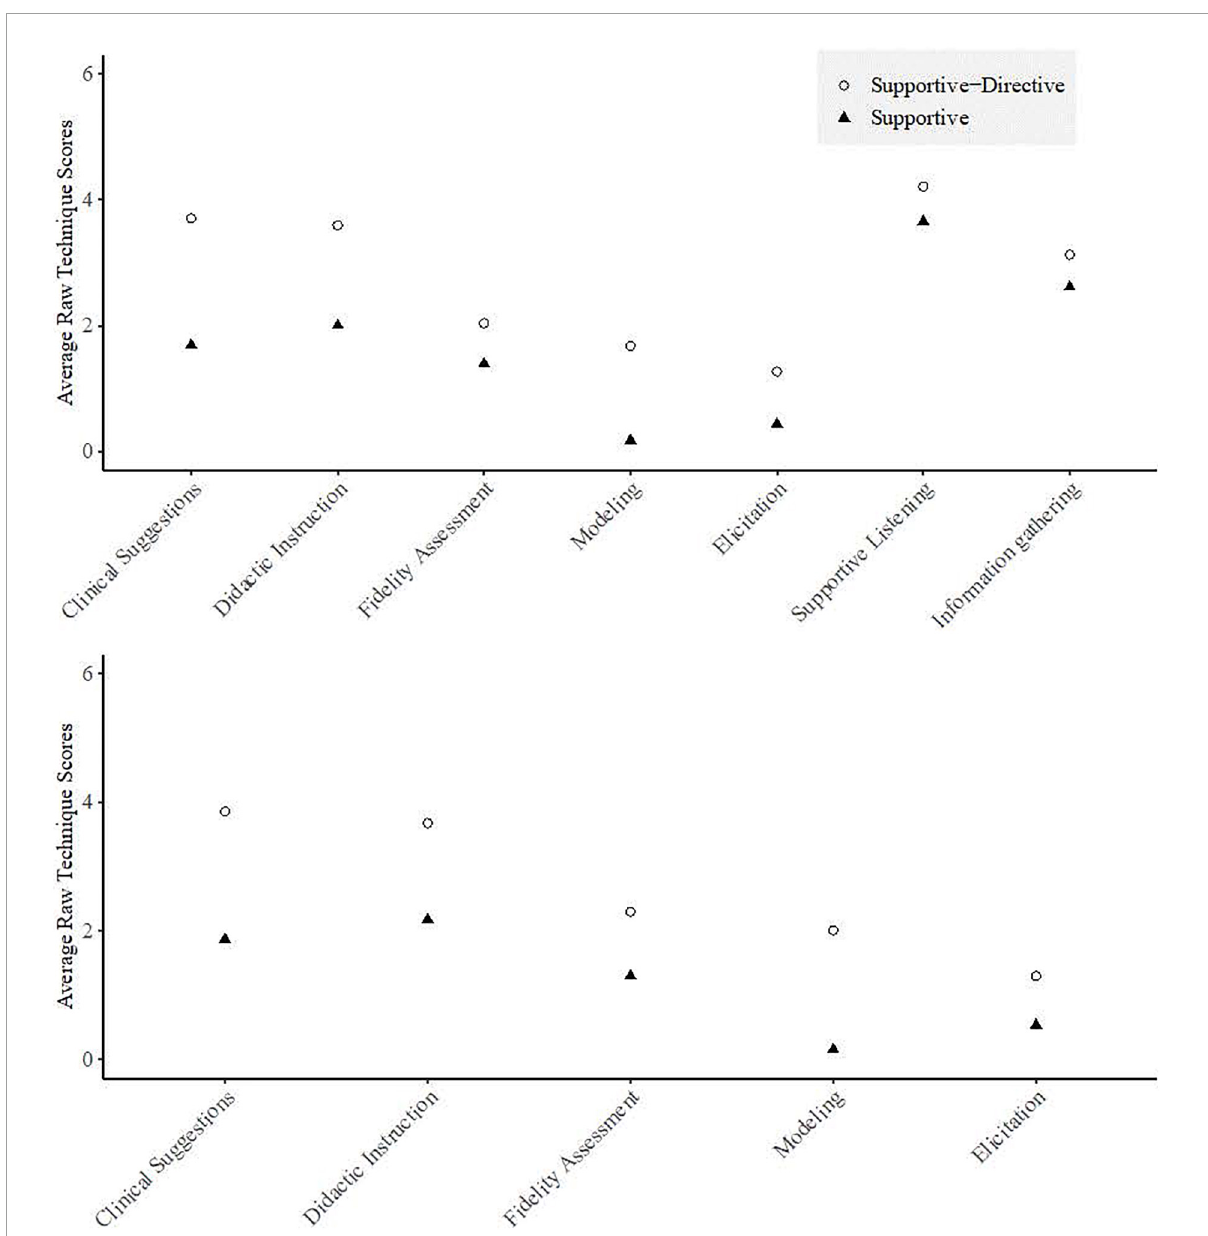
FIGURE1 Average technique scores for the 7 supervision techniques (top) and 5 supervision techniques (bottom)